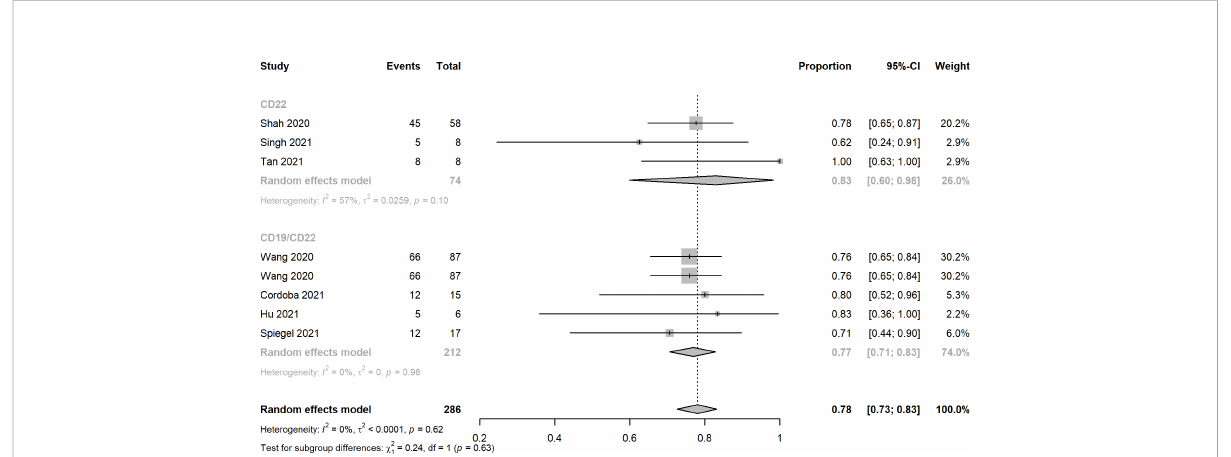
FIGURE 5 Forest plots of neurotoxicity rates of CD22 and CD19/CD22 targeted CAR-T cell therapies for relapsed or refractory B-ALL.